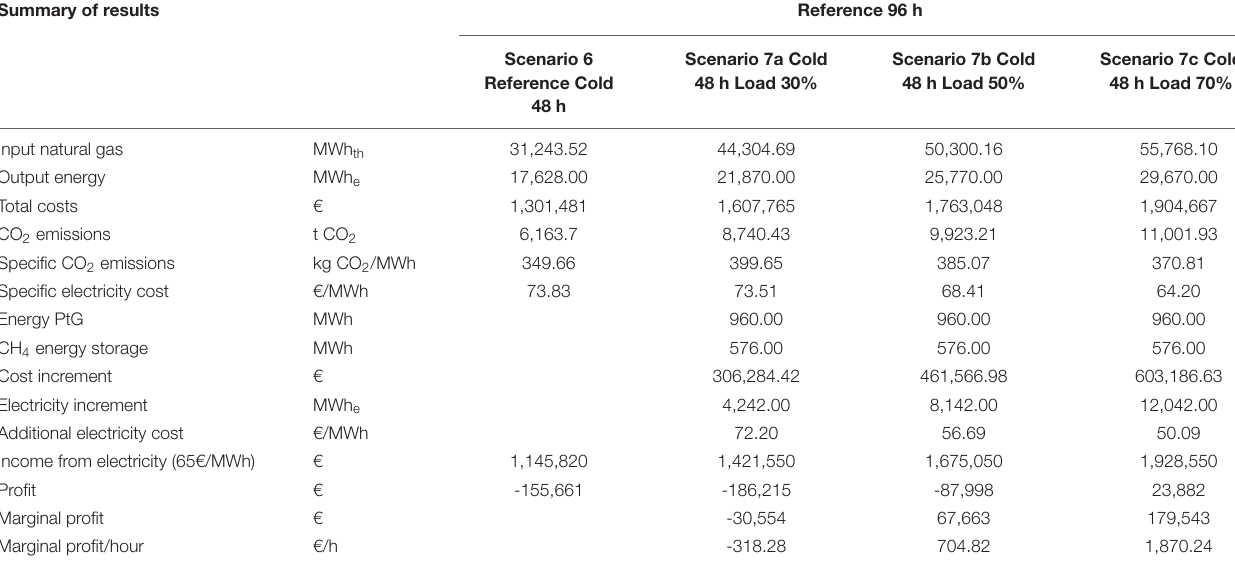
TABLE 6 | Conventional combined cycle power plant (CCPP) vs. PtG-assisted CCPP; cold start-up. Summary of results